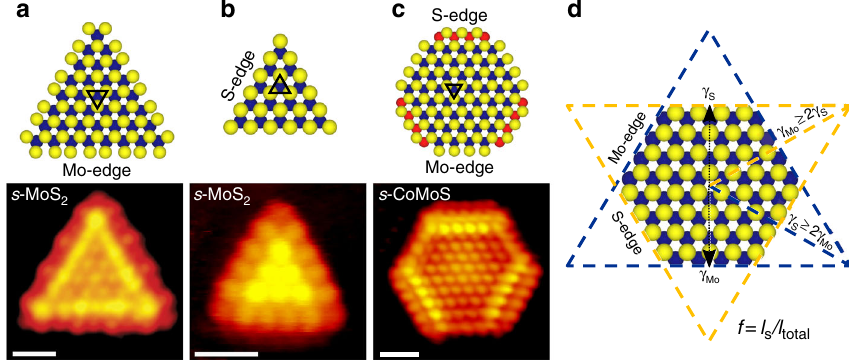
Fig. 1 Top view ball models and atom-resolved STM images of fully sul fi ded nanoclusters 7,8 . a Triangular s- MoS 2 nanocluster terminated by Mo-edges. b Triangular s- MoS 2 nanocluster terminated by S-edges, which is representative only for edge length with less than six Mo atoms, n < 6. c Hexagonal s- CoMoS nanocluster terminated with unpromoted Mo-edges and Co-substituted S-edges. All scale bars are 1 nm. Color code: S: yellow, Mo: blue, Co: red. Black triangles in the basal plane are showed to emphasize the overall orientation of the lattice. d Two-dimensional Wulff construction representing a hypothetical hexagonal MoS 2 nanocluster together with the de fi nition of the shape factor f used in this study, where l s is the accumulated length of the S- edges, and l total is the total edge